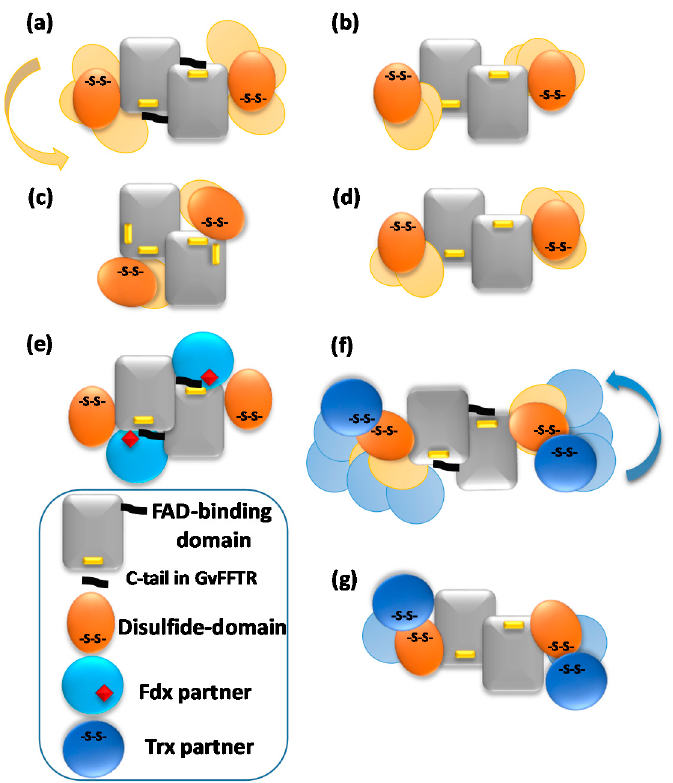
Figure 5. Schematic representations of variability in most representative AFM features for ( a ) GvFFTR; ( b ) CaFFTR2; ( c ) GvDDOR; and ( d ) GvFFTR_ Δ tail homodimers free and in mixtures of GvFFTR_ Δ tail and GvFdx1, as well as for ( e ) transient complexes formed in mixtures of GvFFTR and GvFdx1; ( f ) transient complexes formed in mixtures of GvFFTR and GvTrxm and covalent GvFFTR:GvTrxm and CaFFTR:CaTrx2 heterotetramer complexes; and ( g ) transient complexes formed in mixtures of GvFFTR_ Δ tail and GvTrxm, as well as some CaFFTR:CaTrx2 heterotetramer covalent complexes. Codes for proteins and domains are indicated at the left bottom. Solid forms represent dispositions based on crystal structures (Table A1, when available). Variability envisaged from AFM imaging of disulfide domains or protein partners regarding the central FAD-binding domains of the two protomers is shown in pale colors.